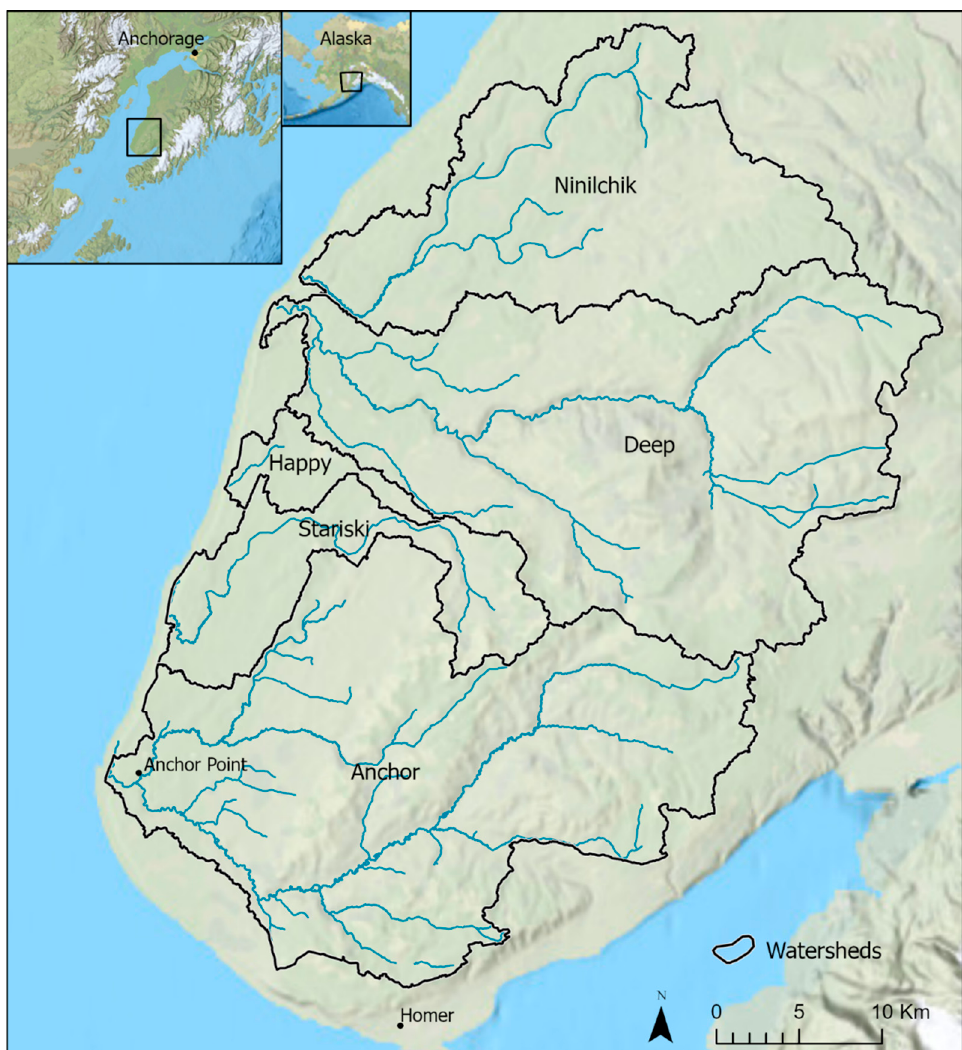
Figure 1. General location of the five watersheds that comprise the study area on the Kenai Peninsula Lowlands. Base map source [57].